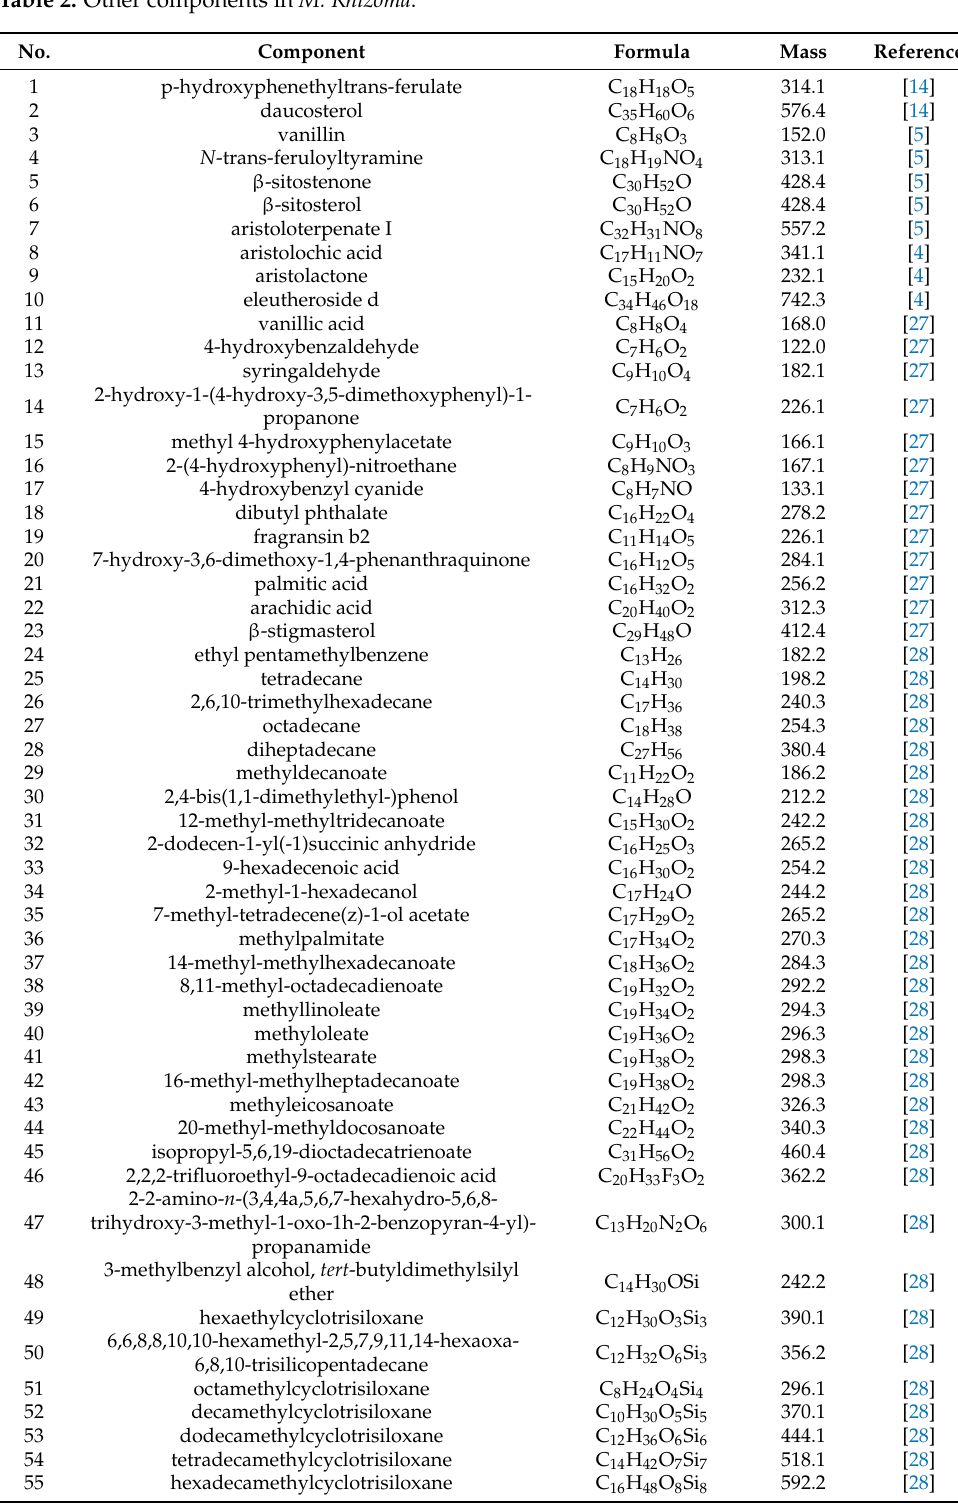
Table 2. Other components in M. Rhizoma